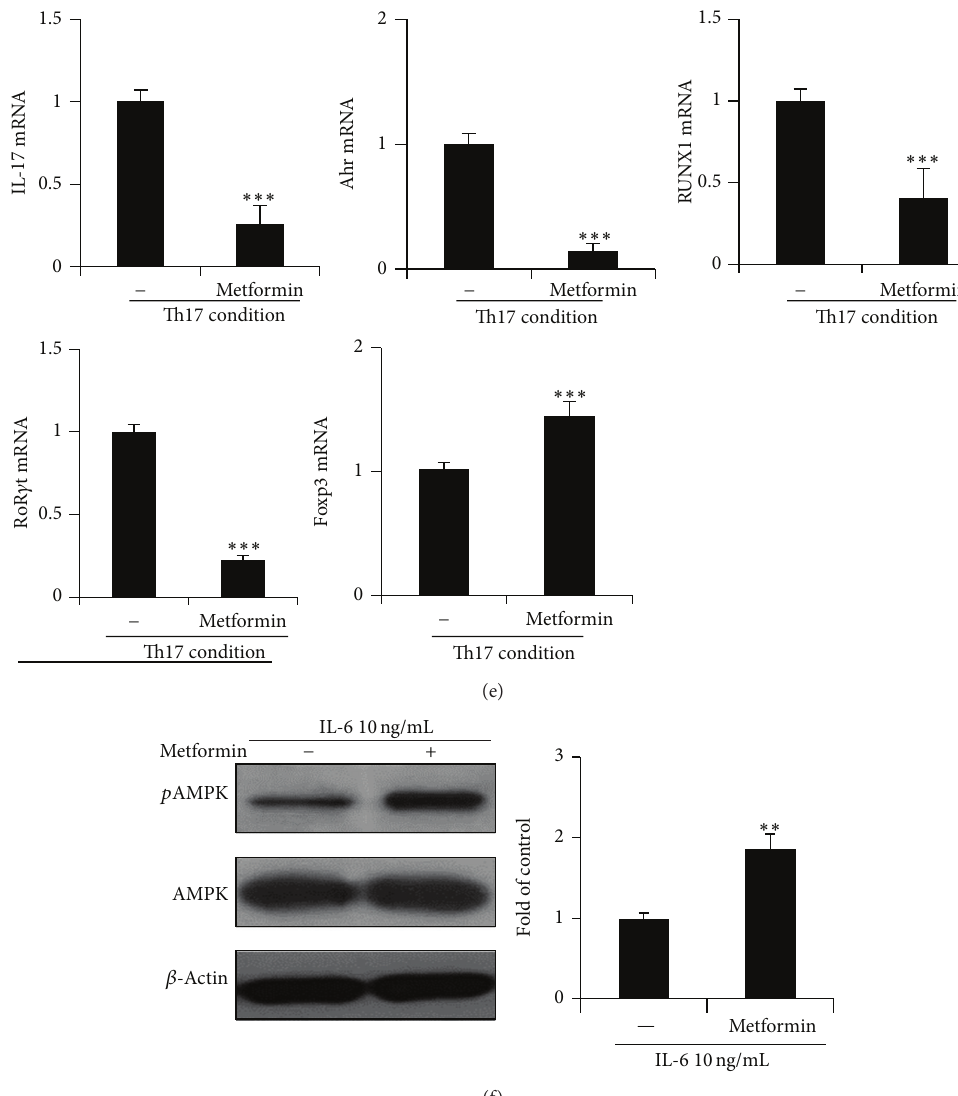
Figure 3: Treatment with metformin Treg cells and decreases Th17 cells in CIA mice and in vitro Th17 polarizing condition. (a–c) Splenocytes were also obtained from metformin-treated CIA ( 𝑛 = 5 ) and control CIA ( 𝑛 = 5 ) on day 35 after first immunization. (a) Both isolated CD4+ T cells were stained with anti-CD25, anti-Foxp3, and anti-IL-17 antibody. The proportions of CD4+IL-17+ T cells and CD4+CD25+ Foxp3+ regulatory T cells were analyzed using flow cytometry. (b) The gene levels of IL-17, Ahr, RUNX1, ROR 𝛾 T, and Foxp3 in splenocytes were determined by real-time PCR. (c) The expressions of phosphorylated AMPK were measured by western blot. The fold of control measured p AMPK/AMPK/ 𝛽 -actin ratio (right). (d–f) Isolated CD4+ T cells of C57BL/6 mice were cultured with under Th17 polarizing conditions in the presence or absence of 1mM metformin for 3 days. (d) The cells were stained with anti-CD4, anti-CD25, anti-IL-17, and anti-Foxp3. (e) The mRNA expression levels of IL-17, Ahr, RUNX1, ROR 𝛾 T, and Foxp3 were determined by real-time PCR. (f) CD4+ T cells were stimulated with IL-6 10ng/mL in the presence or absence of metformin 1mM for 1 hour. The activation of p AMPK was measured by western blot. The representative results are shown in the right panel. Data are presented as the mean ± SD of four independent experiments ( ∗ 𝑃 < 0.05 ; ∗∗ 𝑃 < 0.01 ; ∗∗∗ 𝑃 < 0.005